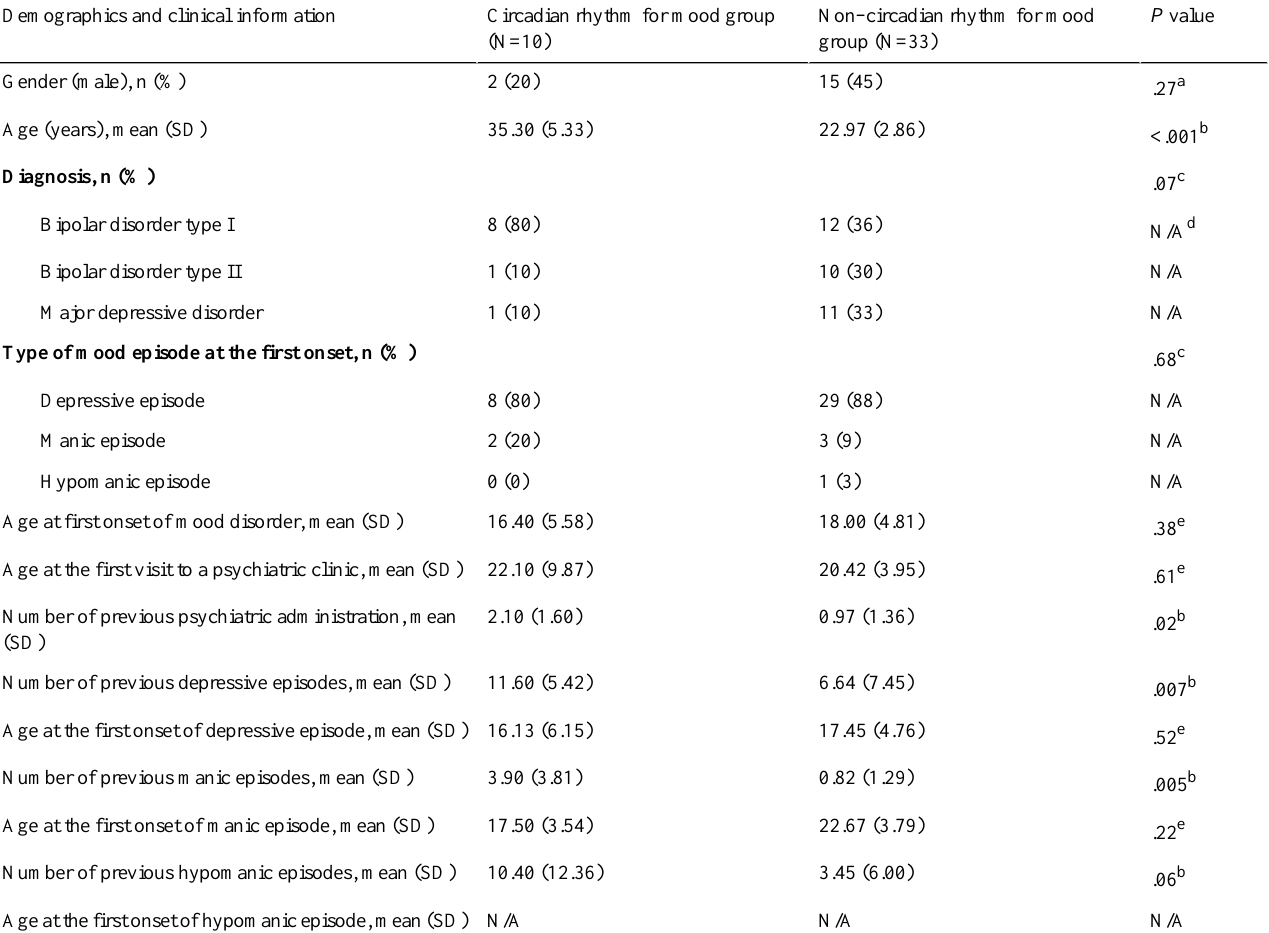
Table 1. Basic demographic and clinical information of the CRM group and non-CRM group.